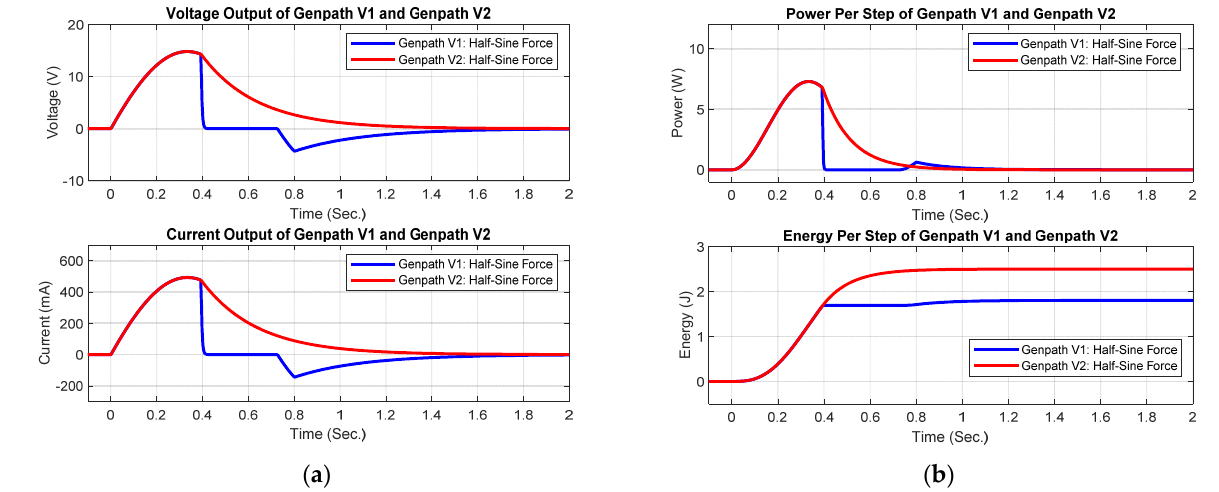
Figure 5. Voltage, current, power, and energy of the Genpath V1 and V2 from simulation when K = 18,000 N/m: ( a ) voltage and current of the Genpath V1 and V2. ( b ) power, and energy of the Genpath V1 and V2. Table 3 . Performances of the Genpath V1 and V2 when 𝐾 = 18,000 N/m Genpath V1 Simulation with Half- Sine Wave Force